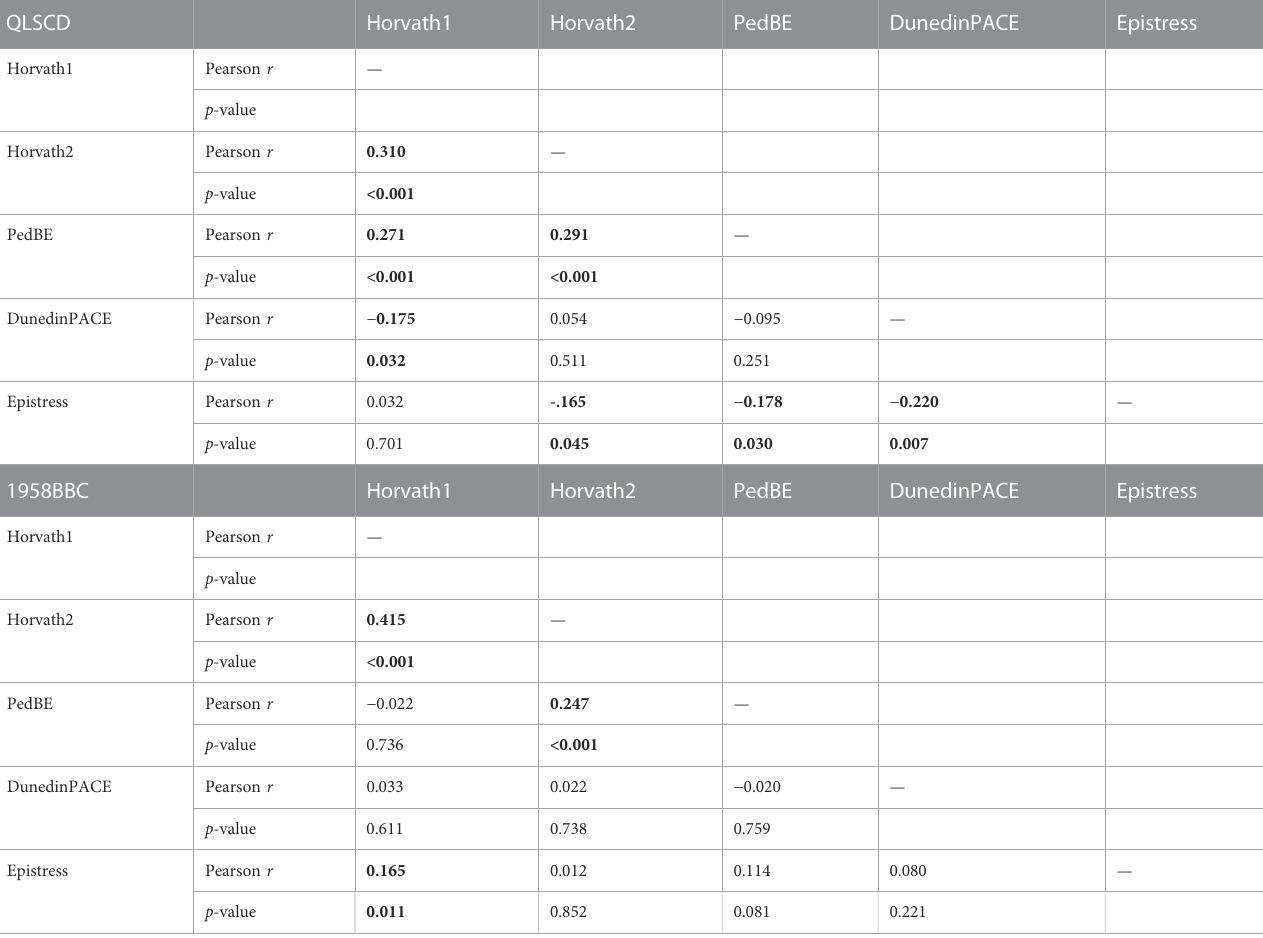
TABLE 2 Correlation matrix for the epigenetic age estimates, DunedinPACE, and Epistress in both cohorts